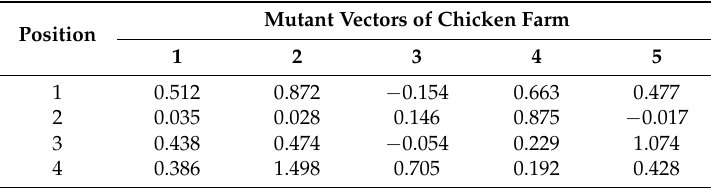
Table 10. Mutant vectors of chicken farm.